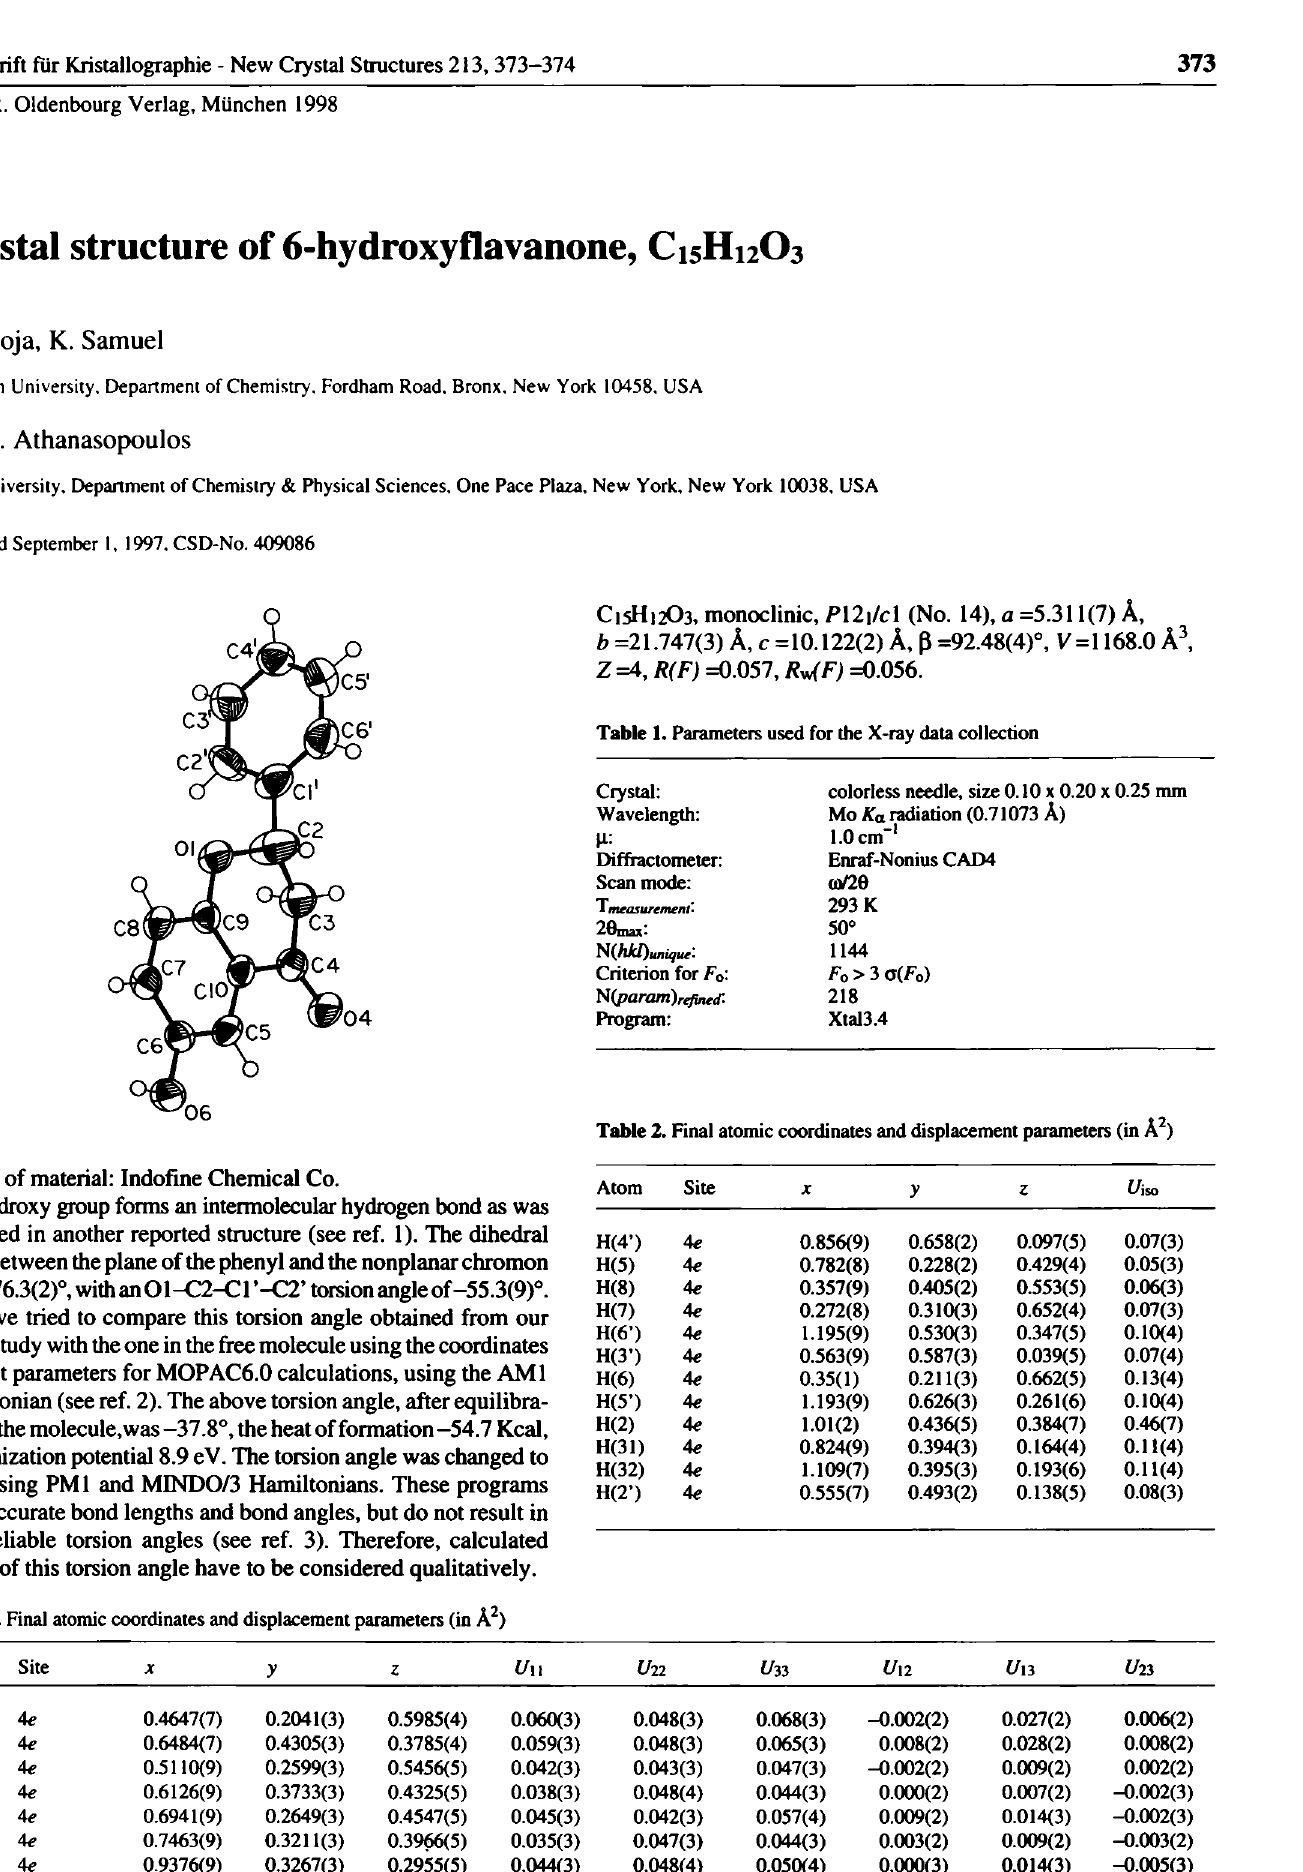
Table 1. Parameters used for the X-ray data collection Crystal: